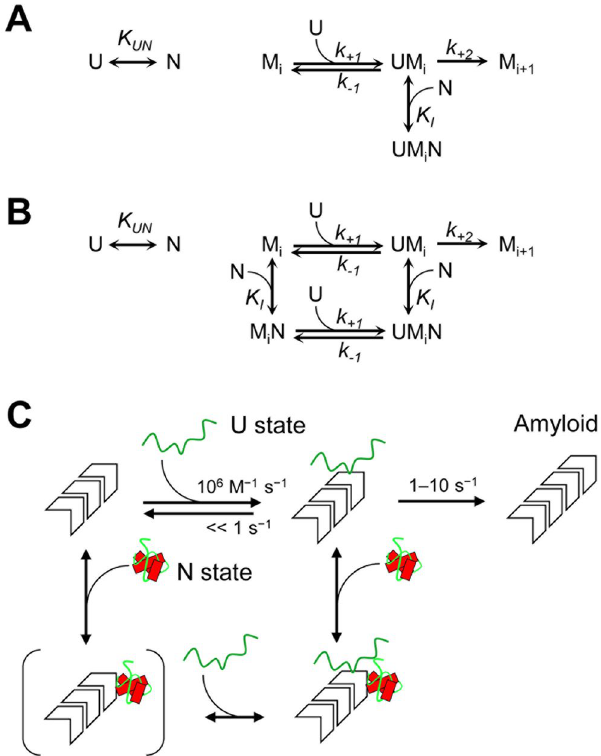
Figure 5. ( A ) Uncompetitive inhibition model (Equation 3). ( B ) Noncompetitive inhibition model (Equation 4). ( C ) A schematic representation of native-state inhibition model. The unfolded (U) state of PrP serves as the direct precursor of amyloid fibrils, whereas the native (N) state inhibits the amyloid formation thorough uncompetitive or noncompetitive